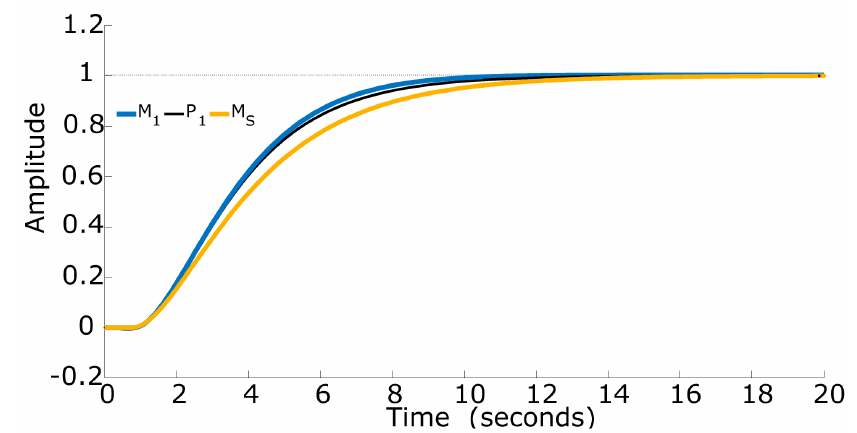
Figure 8. The unit step responses of process P 1 ( s ), model M 1 ( s ), and model M S ( s ).